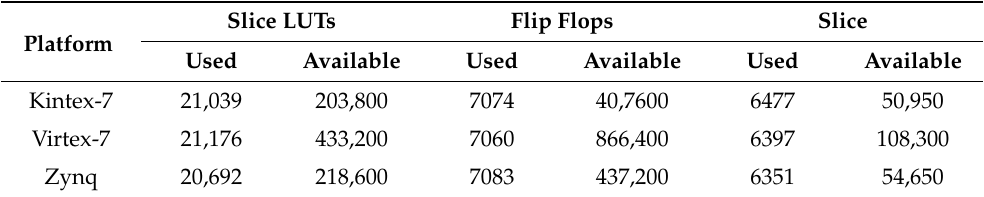
Table 5. Resource consumption of proposed ECSM architecture (256-bit field size).